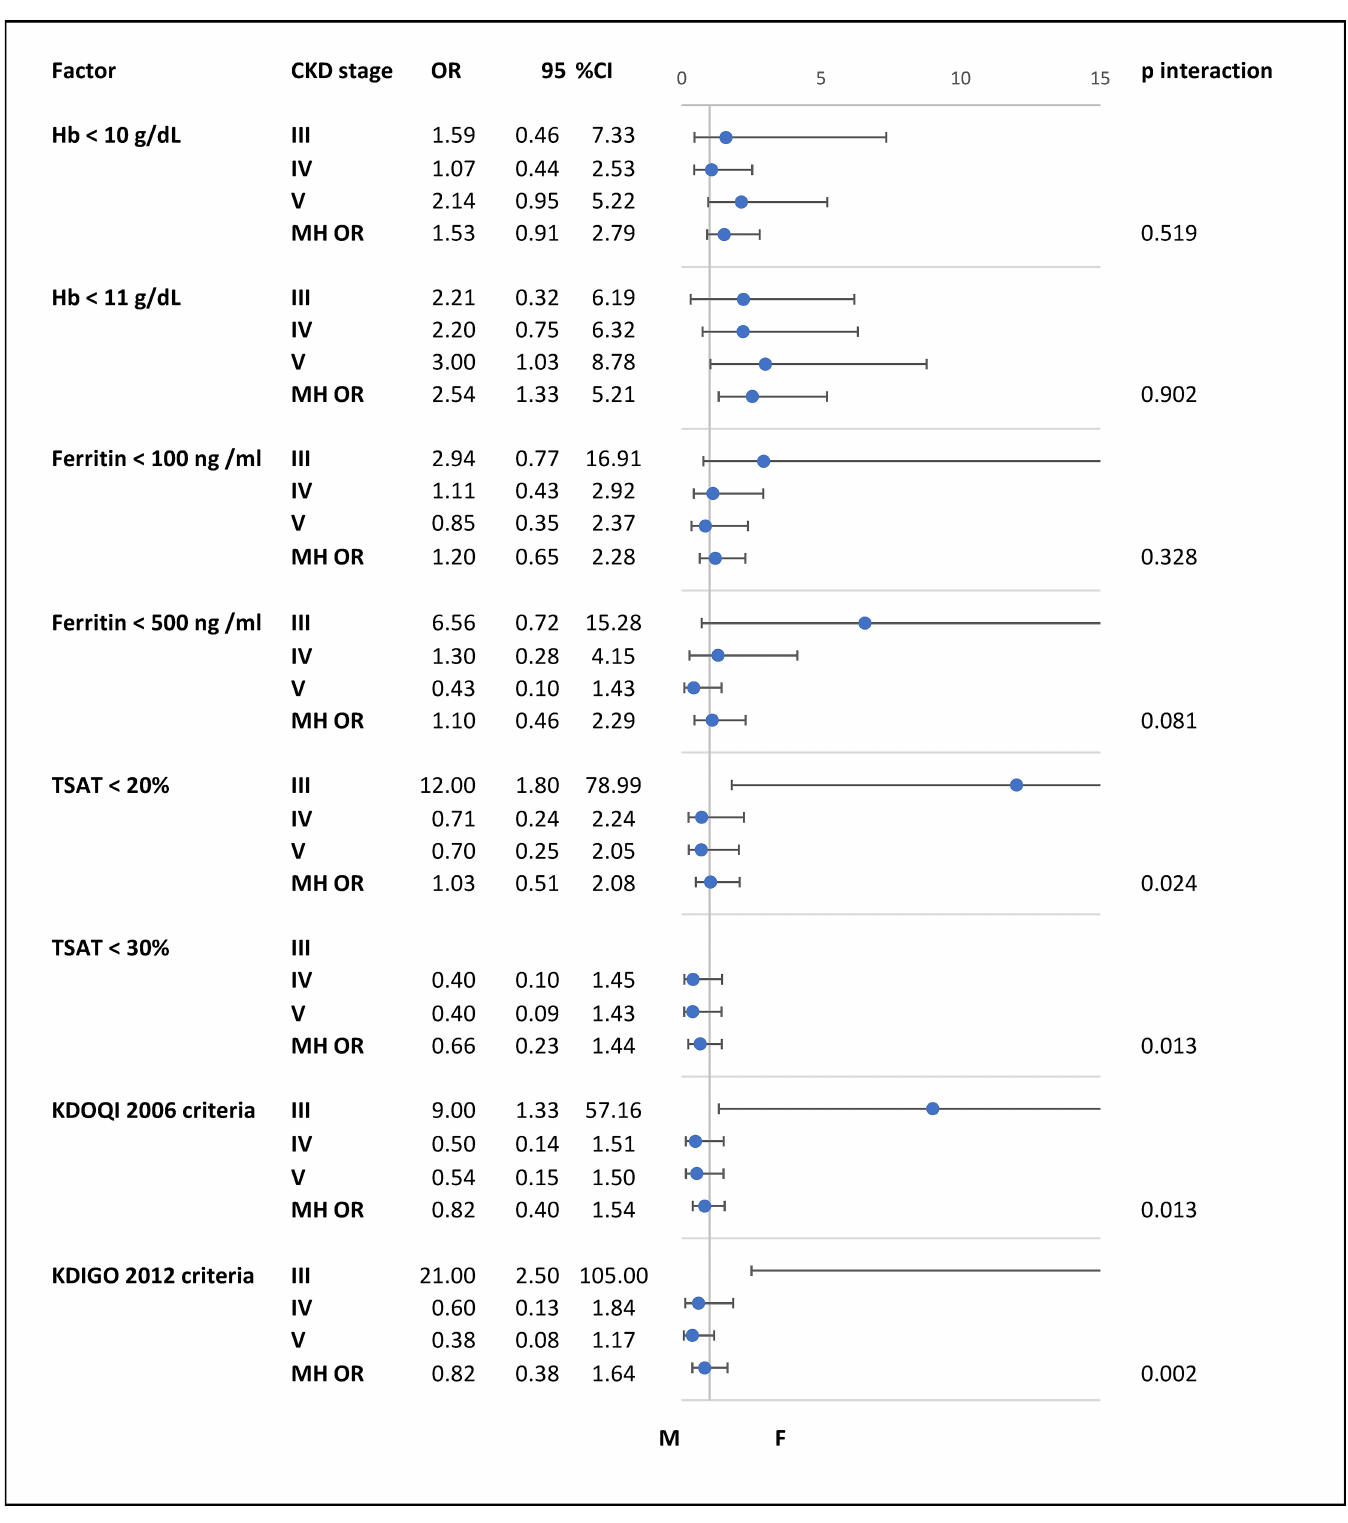
PLOS ONE | https://doi.org/10.1371/journal.pone.0191541 January 22,